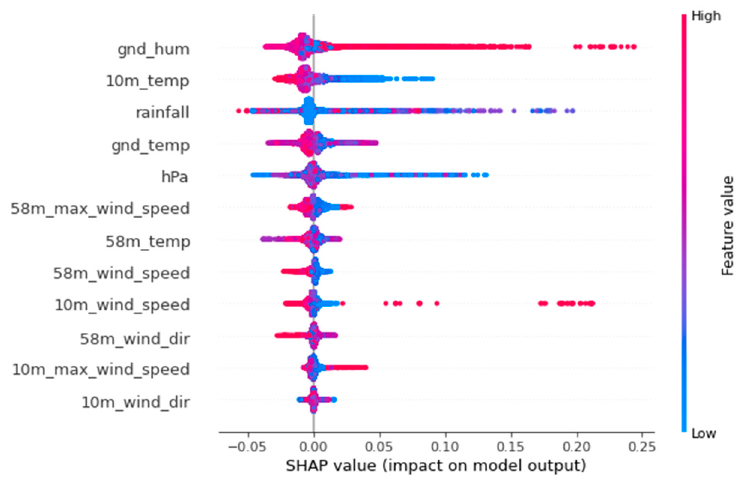
Figure 7. The SHAP value of the LightGBM learning model.